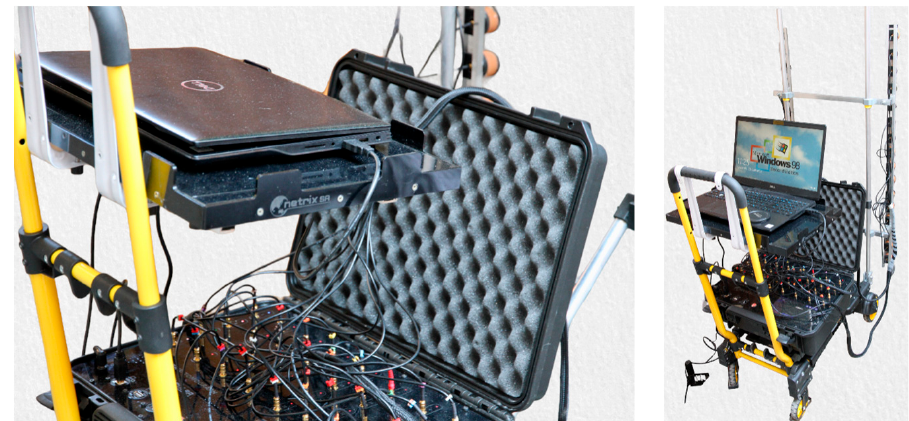
Figure 2. The mobile hybrid tomograph for testing the moisture level of building walls.